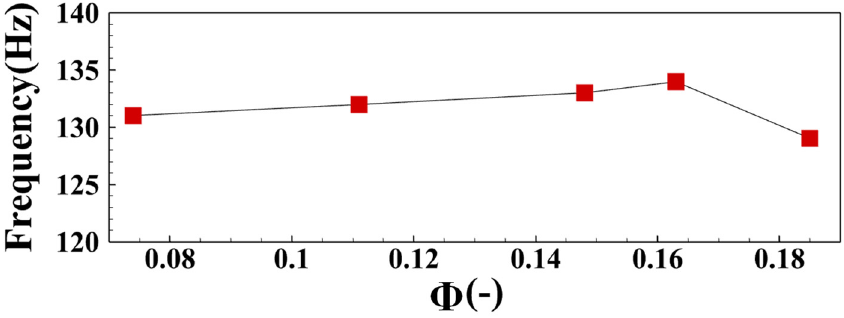
Figure 10. Variation results of CH* pulsation dominant frequency with the equivalence ratio.